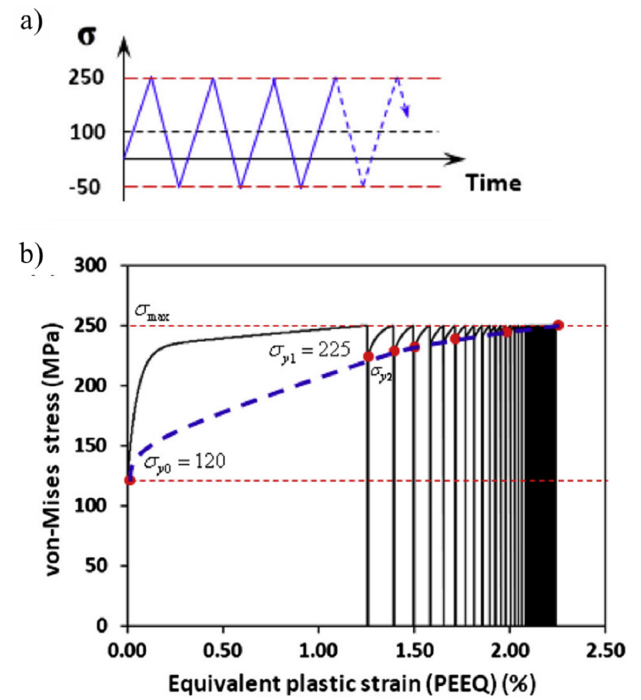
Figure 7. ( a ) Stress-controlled loading for ratcheting simulation employing the NIKH material model; ( b ) cyclic hardening with continuous accumulation of plastic strains [73]. ( b ) cyclic hardening with continuous accumulation of plastic strains